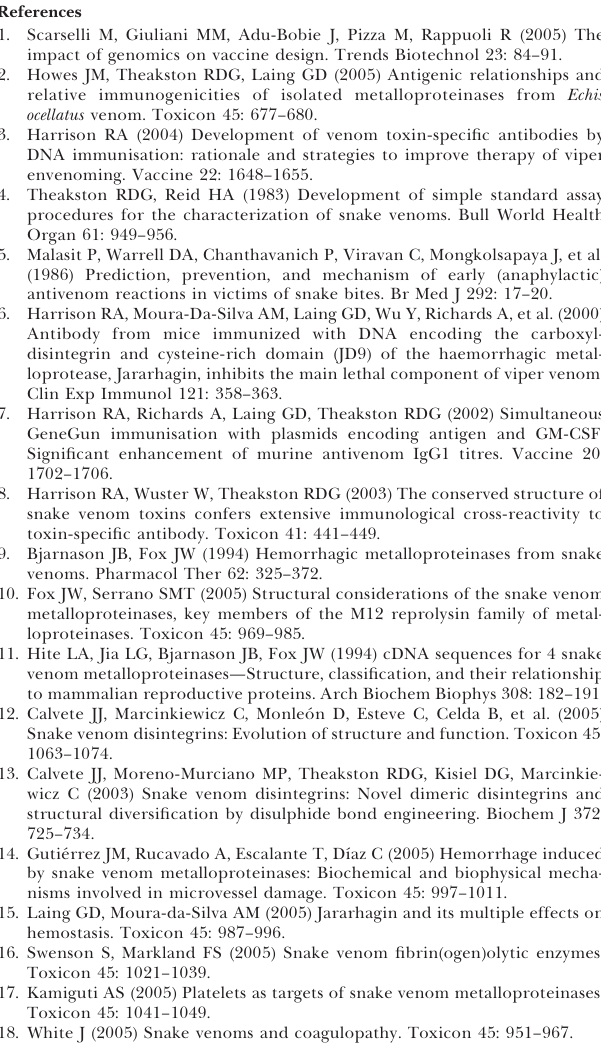
Figure S1. Comparative Sequence Analysis of Full-Length PI-PIII SVMP Isoforms Found at DOI: 10.1371/journal.pmed.0030184.sg001 (144 KB PDF). Figure S2. Composition of the E. ocellatus Venom Gland Tran- scriptome Found at DOI: 10.1371/journal.pmed.0030184.sg002 (83 KB